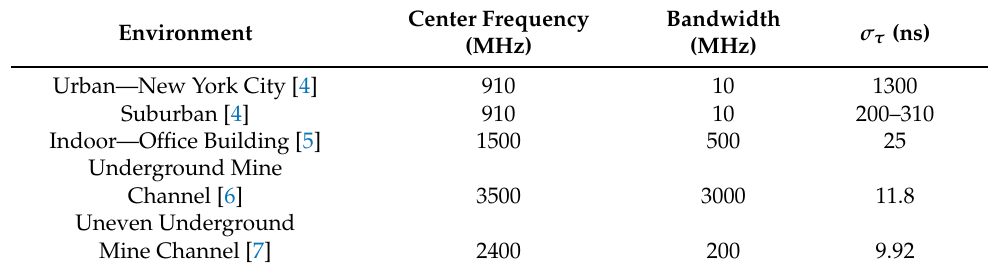
Table 1. RMS Delay Spread typical